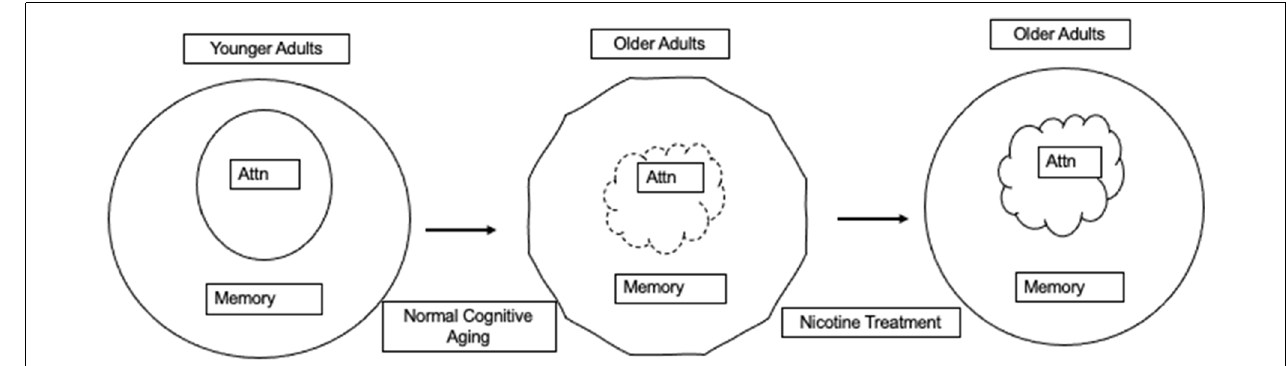
FIGURE 1 | Younger adult cognition is represented with attention supporting normal memory functioning. In normal cognitive aging there is a break down in lower level attentional processes that has the potential to affect memory. We and others hypothesize that nicotinic stimulation can restore nicotinic system functioning resulting in attentional improvements that can also improve